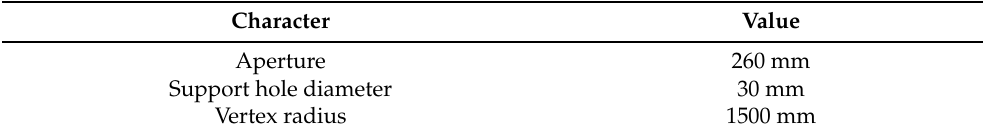
Table 1. Geometric information of primary mirror.